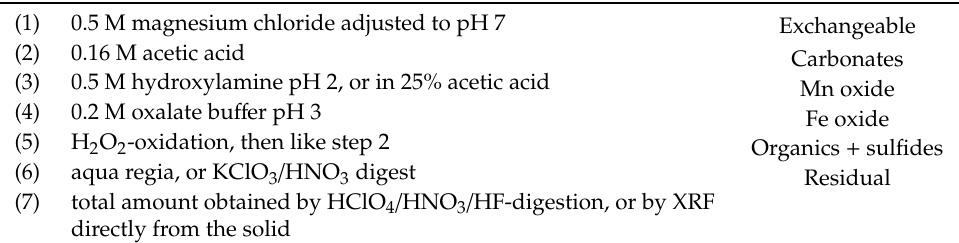
Table 1. Example of a sequential leaching